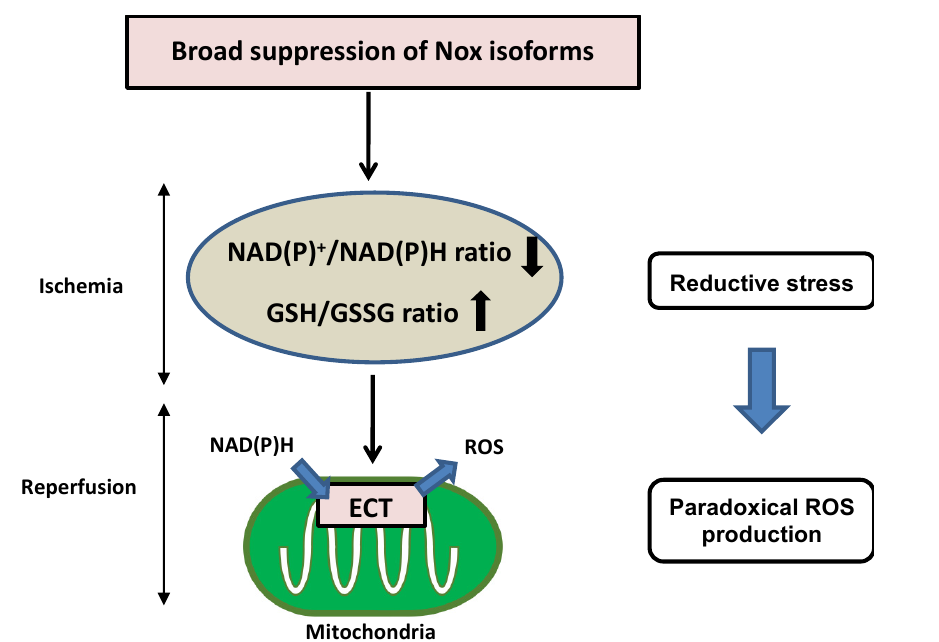
Figure 3. Detrimental effects of reductive stress during myocardial I/R injury. Broad suppression of Nox activity induces a markedly reduced state characterized by decreased NAD(P) + /NAD(P)H and increased GSH/GSSG. Increased reductants paradoxically promote mitochondrial ROS production through the direct transfer of electrons to oxygen in the mitochondrial ETC during ischemia, resulting in no recovery of heart function after reperfusion.